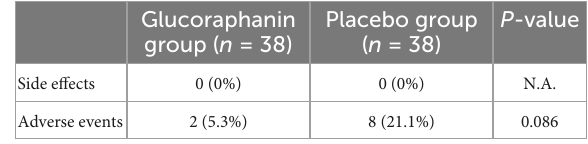
TABLE 3 Incidences of adverse